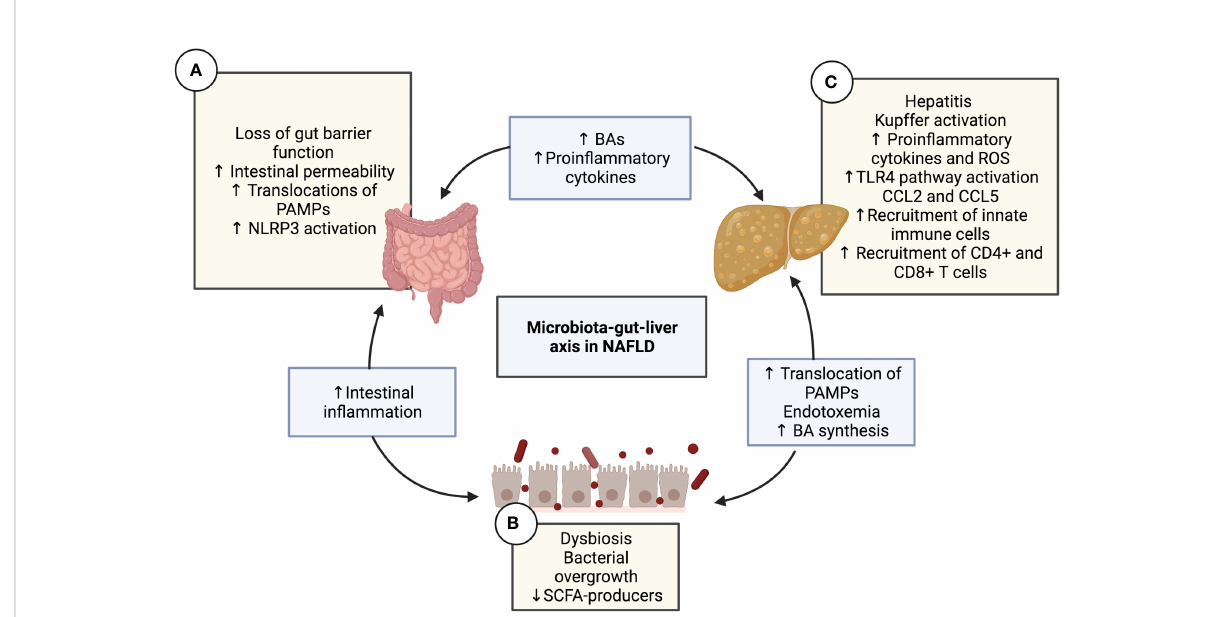
FIGURE 1 The microbiota-gut-liver axis in NAFLD. Interaction diagram of the different mechanisms of the microbiota-gut-liver axis participating in the pathogenesis of NAFLD. (A) Intestinal gut barrier disruption and increased permeability have been demonstrated in patients with NAFLD along with the decreased expression of junctional adhesion molecule A, zonula occludens-1, and occludin. This alteration causes the transfer of pro- in fl ammatory products and PAMPs (such as LPS or PGN) to the liver circulation, con fi guring intestinal in fl ammation and endotoxemia. The translation of PAMPs causes TLR signaling in the mucosa, which leads to the activation of NLRP3. (B) Diet nutrient composition can affect the quantitative and qualitative composition of the gut microbiota, leading to intestinal dysbiosis and bacterial overgrowth, which impacts the immune response, favoring NAFLD progression. Dysbiosis contributes to the disruption of the intestinal barrier, increasing mucosal permeability, which produces more dysbiosis, thereby creating a vicious cycle. Another consequence of dysbiosis is the alteration in the homeostasis of microbe- derived metabolites, such as a decrease in SCFAs and an increase in BAs. (C) The liver is a vital organ in fat metabolization and undergoes many changes in patients with metabolic syndrome, including the over-accumulation offree fatty acid, activation of KCs due to and the TLR4 pathway, lipotoxicity, increased reactive oxygen species and cytokines, and fi nally, steatosis. Hepatic CCL5 expression levels have been shown to increase in NAFLD patients. The release of the chemokines CCL2 and CCL5 is crucial in the recruitment of lymphocytes to the liver. The migration of mesenteric lymph node cells into the liver is mediated by CCL5, which induces hepatic CD4+ T and CD8+ T cell activation, subsequently leading to liver injury and the progression of NAFLD. BA, Bile acid; CD, Cluster of differentiation; CCL, C-C motif chemokine ligand; KC, Kupffer cell; LPS, Lipopolysaccharide; NAFLD, Non-alcoholic fatty liver disease; NLRP3, NLR family pyrin domain containing 3; PAMP, pathogen-associated molecular pattern; PGN, Peptidoglycan; ROS, Reactive oxygen species; SCFA, Short-chain fatty acid; TLR, Toll-like